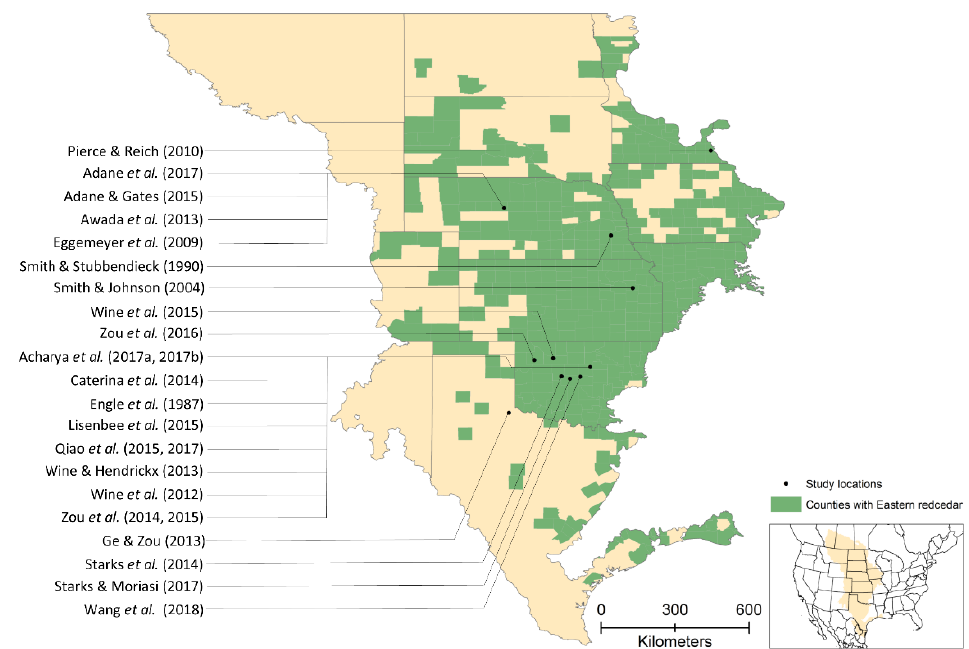
Figure 2. Counties with redcedar documented in the Great Plains and studies conducted in the Great Plains that document changes in the hydrology of the system as a result of redcedar encroachment. The majority of hydrological studies have employed experimental manipulations in locations where grasslands have undergone regime shifts to juniper woodland (e.g., Oklahoma) [23–38]. Fewer studies have employed simulations or scenario analyses to assess the relative vulnerability of regions where grasslands are still intact, but at the early stages of redcedar encroachment (e.g., states in the Northern Great Plains), to delineate potential impacts to water resources with future spread and grassland conversion[39–45].